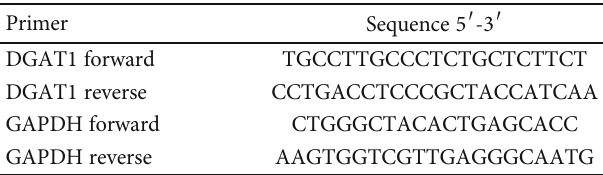
Table 1: Primers used in this